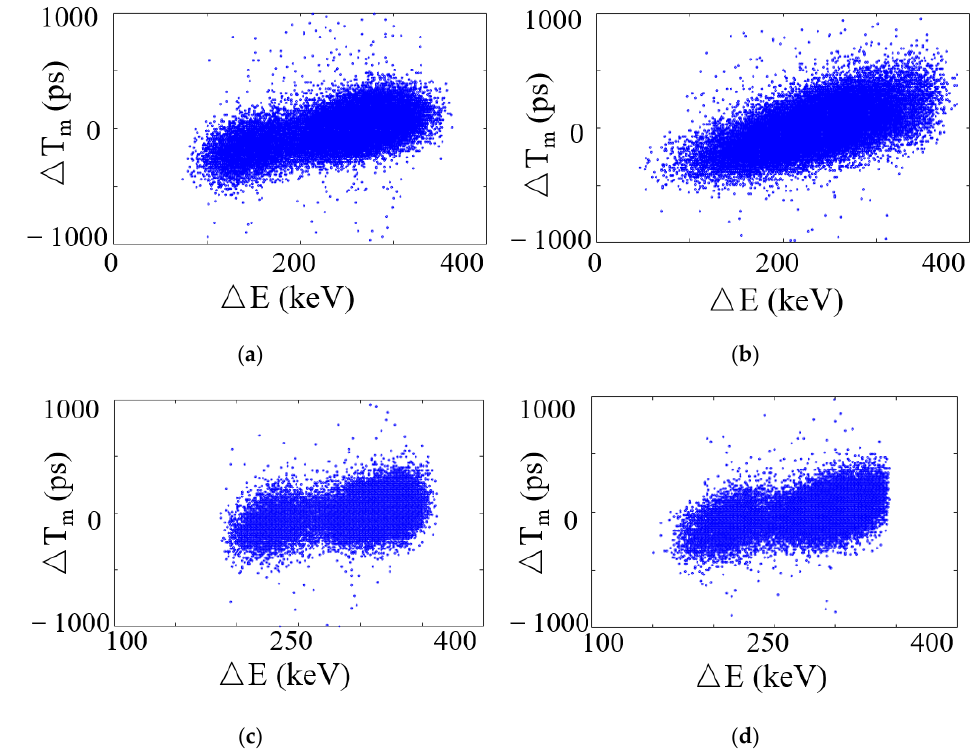
Figure 8. Scatterplots of ∆𝑇 𝑚 and ∆𝐸 of ( a ) SiPM 1 of dual-ended readout, ( b ) SiPM 1 of side dual-ended readout, ( c ) SiPM 1, and ( d ) SiPM 3 of triple-ended readout detector.